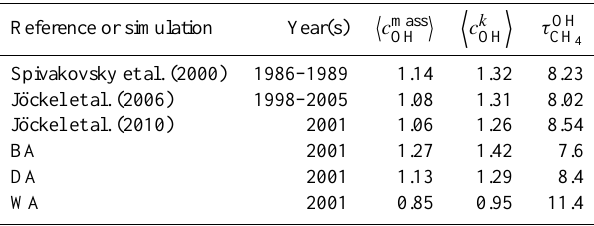
Table 2. Global mean hydroxyl radical concentrations (in 10 6 cm − 3 ) and corresponding tropospheric methane lifetimes ( τ CH , in years) with respect to CH 4 + OH → CH 3 + H 2 O (Re- 4 action R4). Methane lifetimes for BA, DA and WA are calculated with the recommended reaction rate coefficient for (R4) from Atkin- son (2003). The upper boundary is the climatological tropopause defined by Eq. (8). The values of Spivakovsky et al. (2000) are based on observations of CH 3 CCl 3 , HCFC-22, and precursors for HO x - NO x